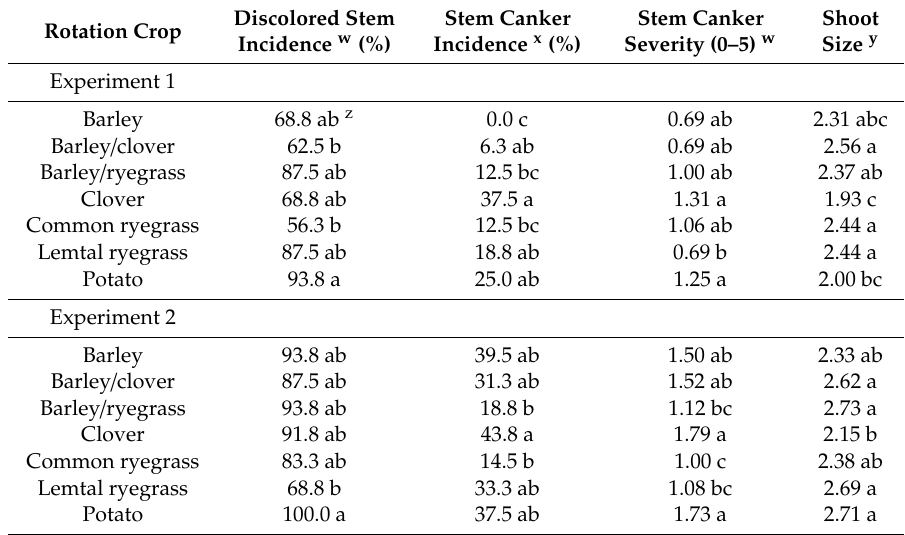
Figure 1. Soil populations of R. solani prior to and after incorporation of rotation crop residues in repeated greenhouse trials for ( A ) experiment 1 and ( B ) experiment 2 and soil populations of R. zeae in ( C ) experiment 1 after incorporation of residues and ( D ) experiment 2 both prior to and after incorporation of residues. Inoculum of R. solani Anastomosis Group (AG)-3 was added at the start of each experiment. Table 1. Effects of preceding rotation crops on stem canker and size of potato shoots in greenhouse experiments.